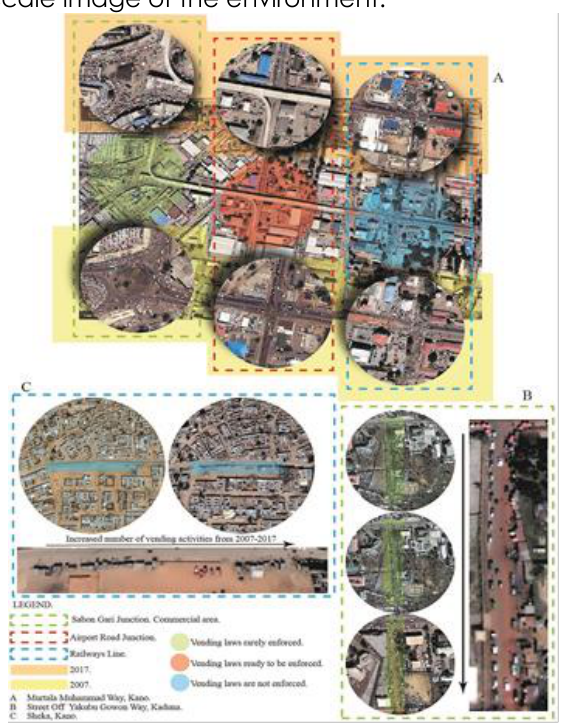
Figure 3 : Spatial distribution of vendors in different urban centres. It shows areas that are hostile to vending activities and those that are not. Within A, it can be seen that different configuration of the urban environment and accompanying land uses (commercial, institutional and derelict lands) influences the extent to which the law is applied. Source: Authors,